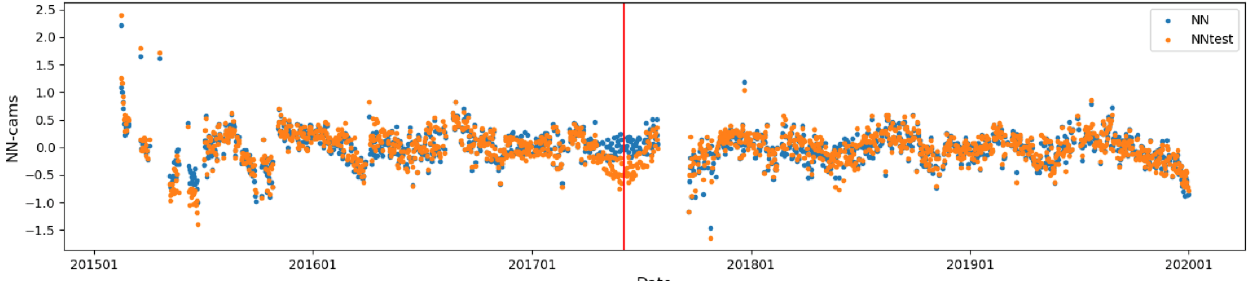
Figure A1. Mean difference, at daily scale, between the NN XCO 2 estimate and the CAMS model. The blue dots show the results for the nominal training. The orange dots show the results when the training was made with a dataset biased by 1ppm but only the observations of June 2017, the center of which is indicated by the red vertical line.